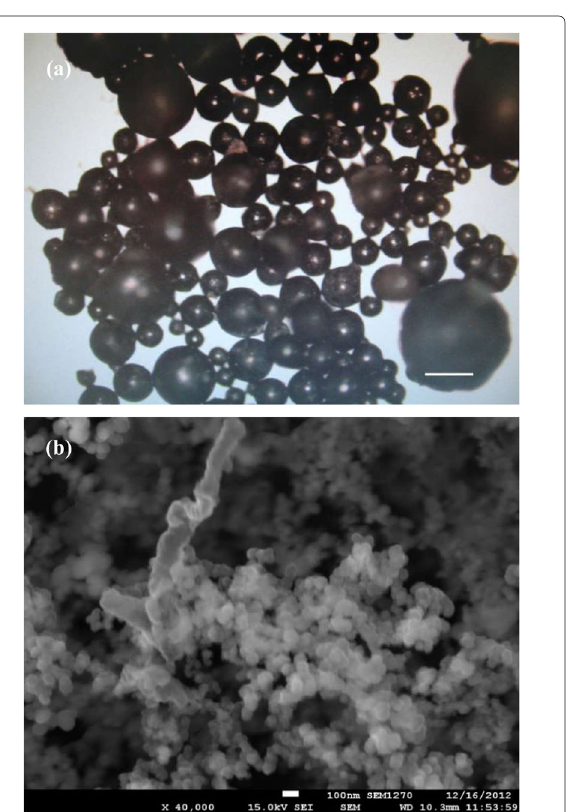
Fig. 3 a Glass-quenched droplets collected from inside the chamber. Scale bar = 100 μ m. They are generally spherical in shape, with a flat face on one side that results from collision with a Cu-plate or the chamber wall. Necking between the spherules is an optical artifact. b SEM image of the condensed particles collected on a filter paper. Scale bar = 100 nm. Globules of 100 nm or less in diameter are 3-dimensionally connected to one another